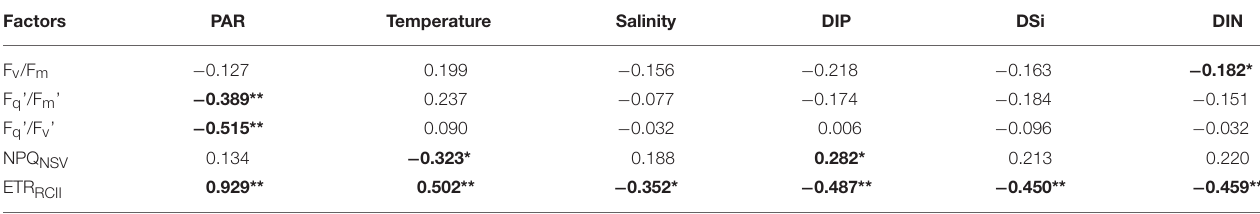
TABLE 1 | Pearson’s rank correlation coefficients between photosynthetic parameters and environmental factors. Factors PAR Temperature Salinity DIP